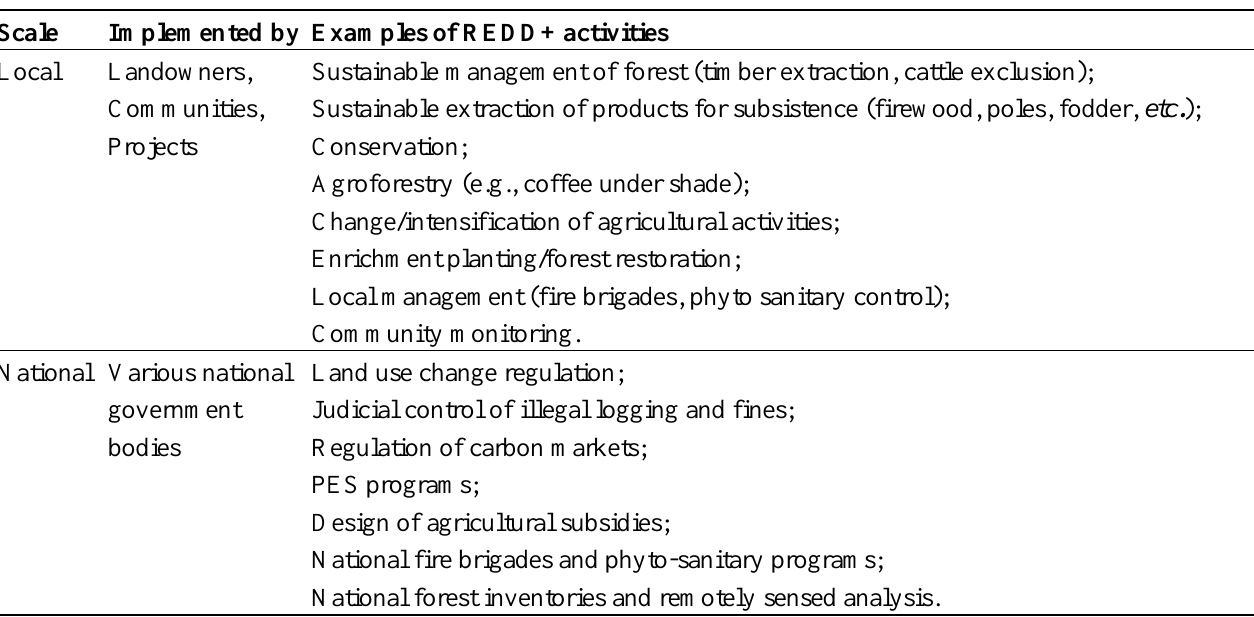
Table 1. Examples of REDD+